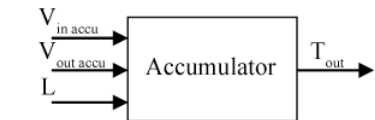
Fig. 3. Input / Output scheme of the accumulator